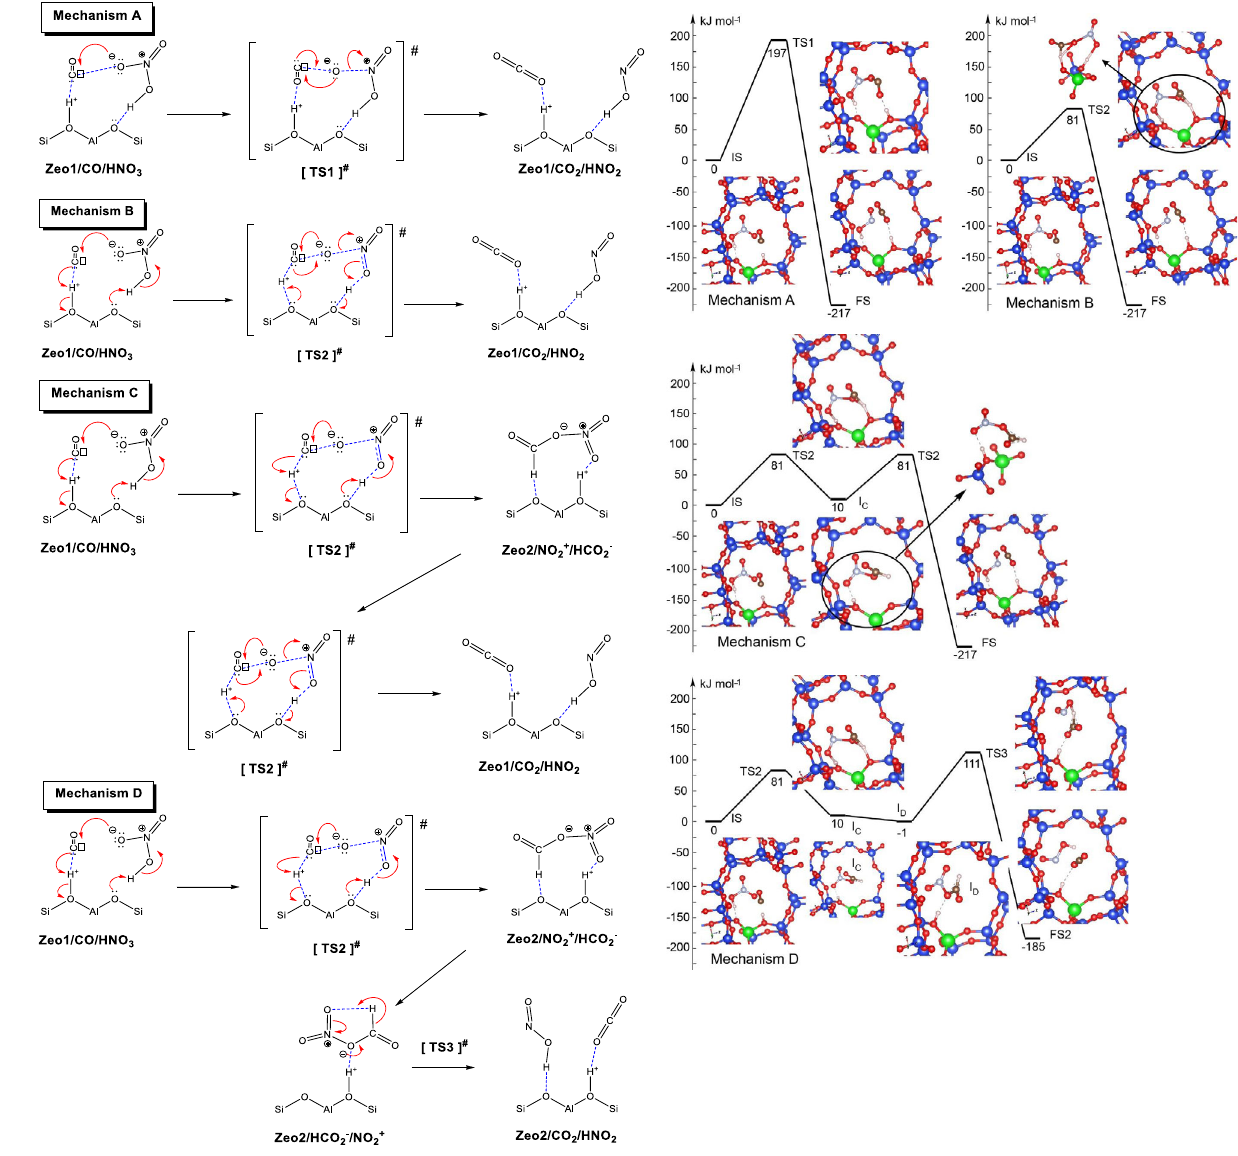
Fig. 4 Mechanisms A, B, C, and D of CO oxidation by HNO 3 in H-CHA. Zeolite structures Zeo1 and Zeo2 differ by the different locations of the zeolite proton at basic O centers from the AlO 4 unit. The fi rst species given after Zeo1 and Zeo2 are the one which interacts with the zeolite proton. Corresponding energy diagrams of the investigated mechanisms (Mechanisms A, B, C, and D) for CO oxidation by HNO 3 in H-CHA. The corresponding structures are also shown. Shorter names are used for the structures in the energy diagrams with respect to the schemes above as: IS – Zeo1/CO/HNO 3 ; FS – Zeo1/CO 2 /HNO 2 ; I C – Zeo2/NO 2 + /HCO 2 − ; I D – Zeo2/HCO 2 − /NO 2 + , FS2 – Zeo2/CO 2 /HNO 2 . Color coding: Si – blue, O – red, Al – green, N – light blue, C – brown, H –